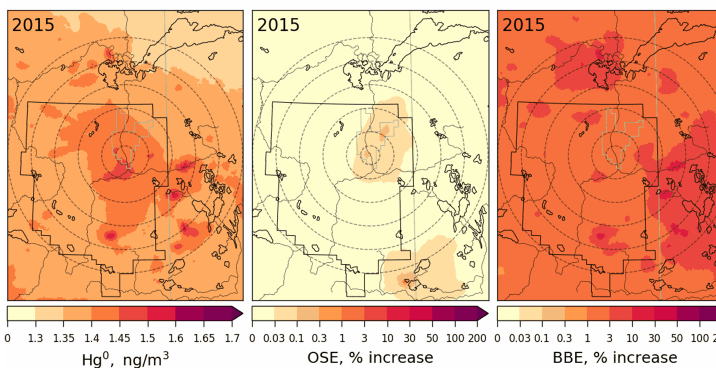
Figure 12. Annual average surface air concentration of GEM (left) and concentration enrichments (%) due to Hg emissions from Athabasca oil sands operations (OSE, middle) and biomass burning in North America (BBE, right) for the years 2012 to 2015. The AOSR is marked as an approximate rectangle, and concentric distance circles are at 20, 50, 100, 150, 200 and 250km from